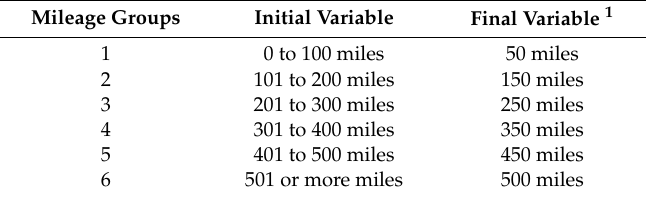
Figure 1. Mileage groups for the N = 929 active sport event participants. The columns indicate the number of miles traveled for each group. Table 1. Mileage Groups for the N = 929 Active Sport Event